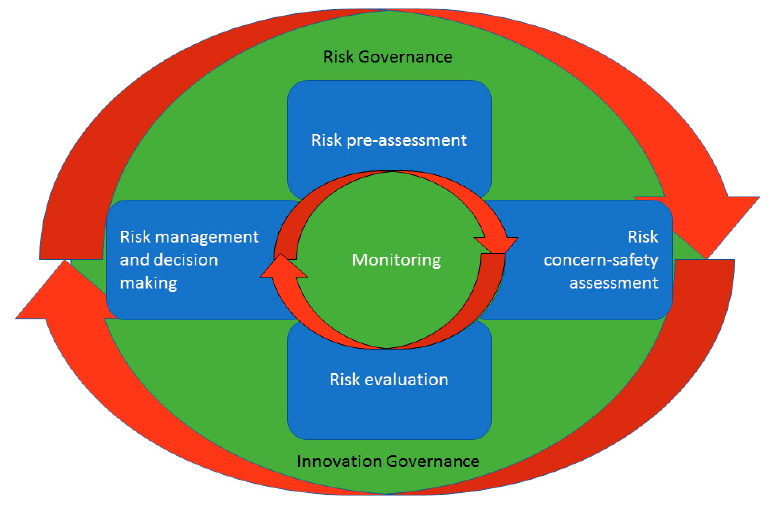
Figure 1. Common elements of the risk governance frameworks for nanomaterials .